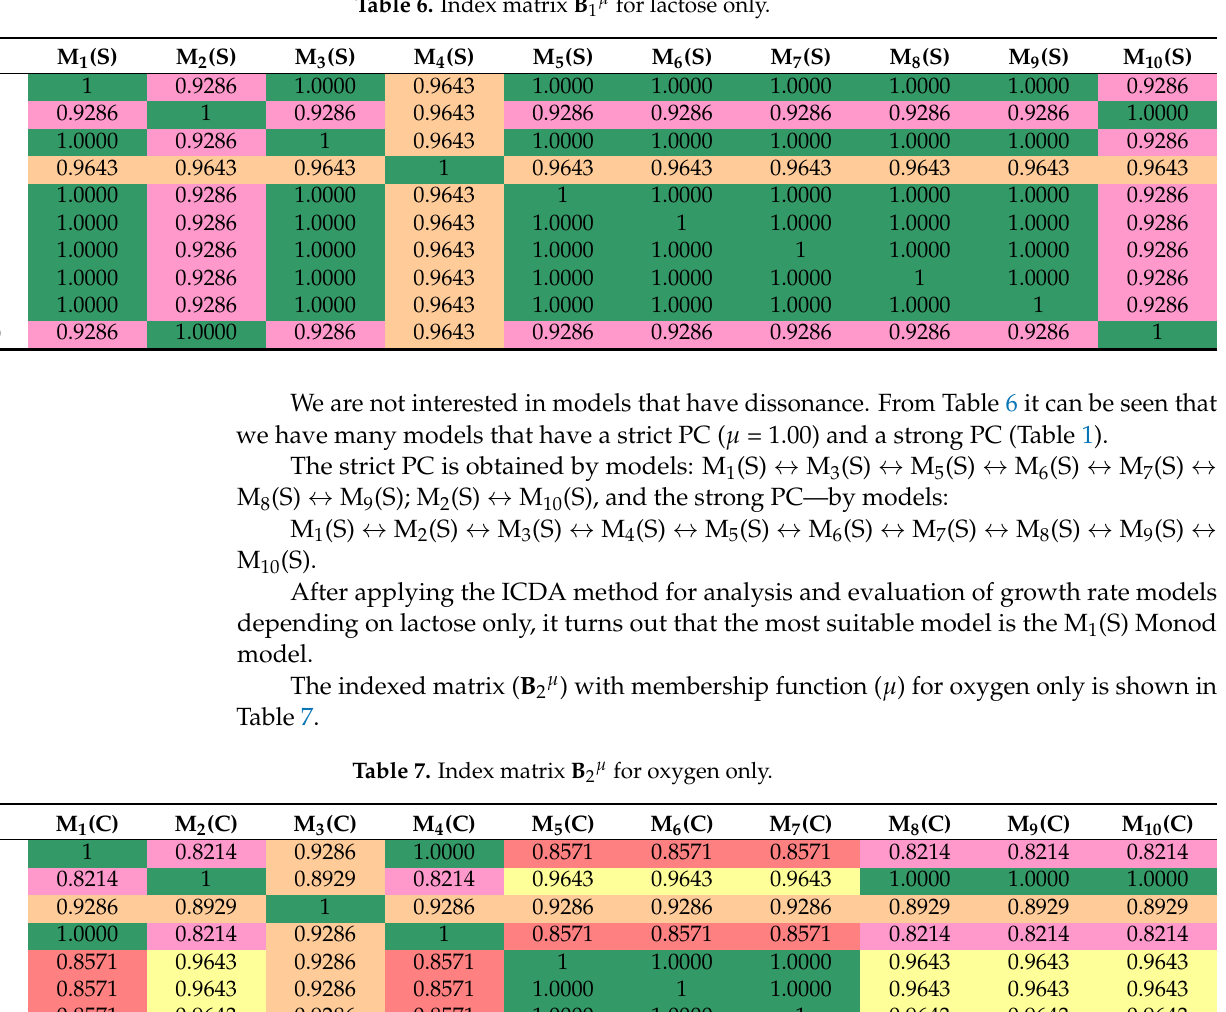
Table 6. Index matrix B 1 µ for lactose only.